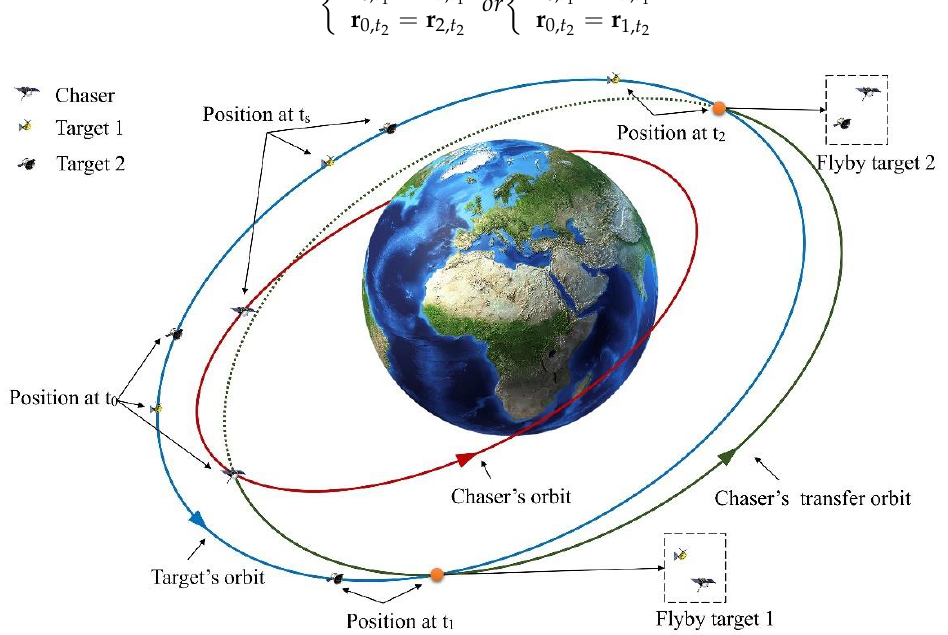
Figure 1. Geometric interpretation of a single-impulse flyby two co-orbital spacecraft problem.